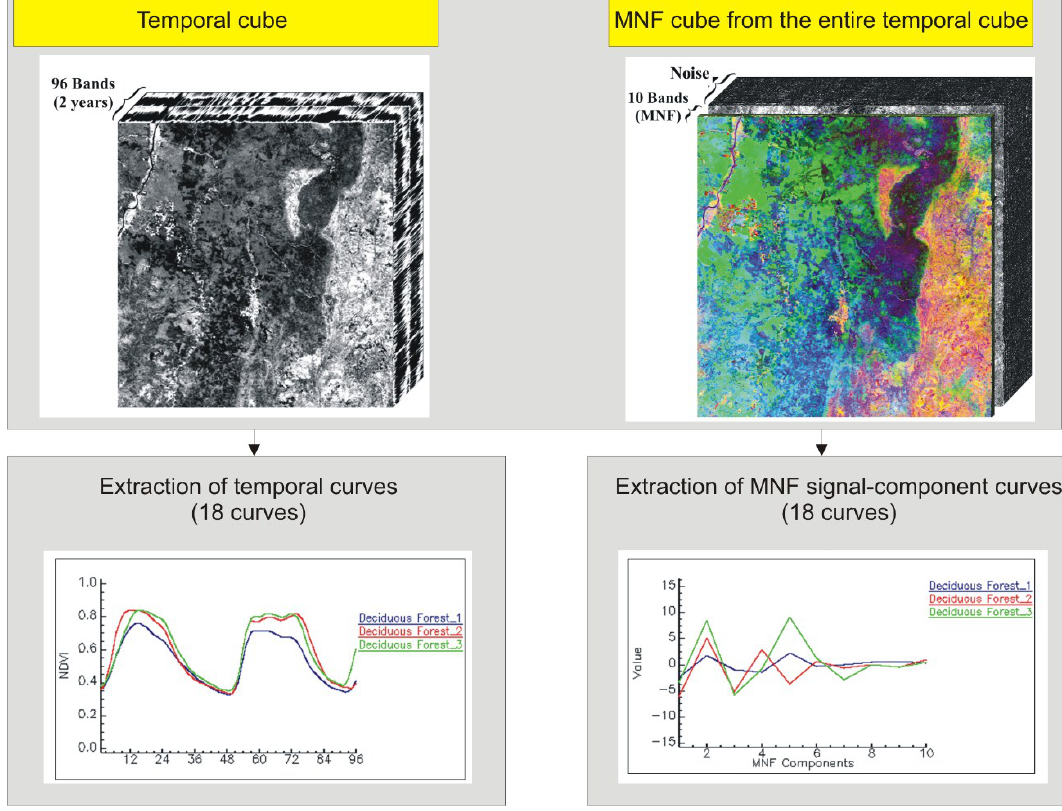
Figure 3. Procedure for the temporal-signature selection of land use and vegetal cover considering both the MODIS-NDVI data dimension and the actual dimensions of images from signal components of the MNF